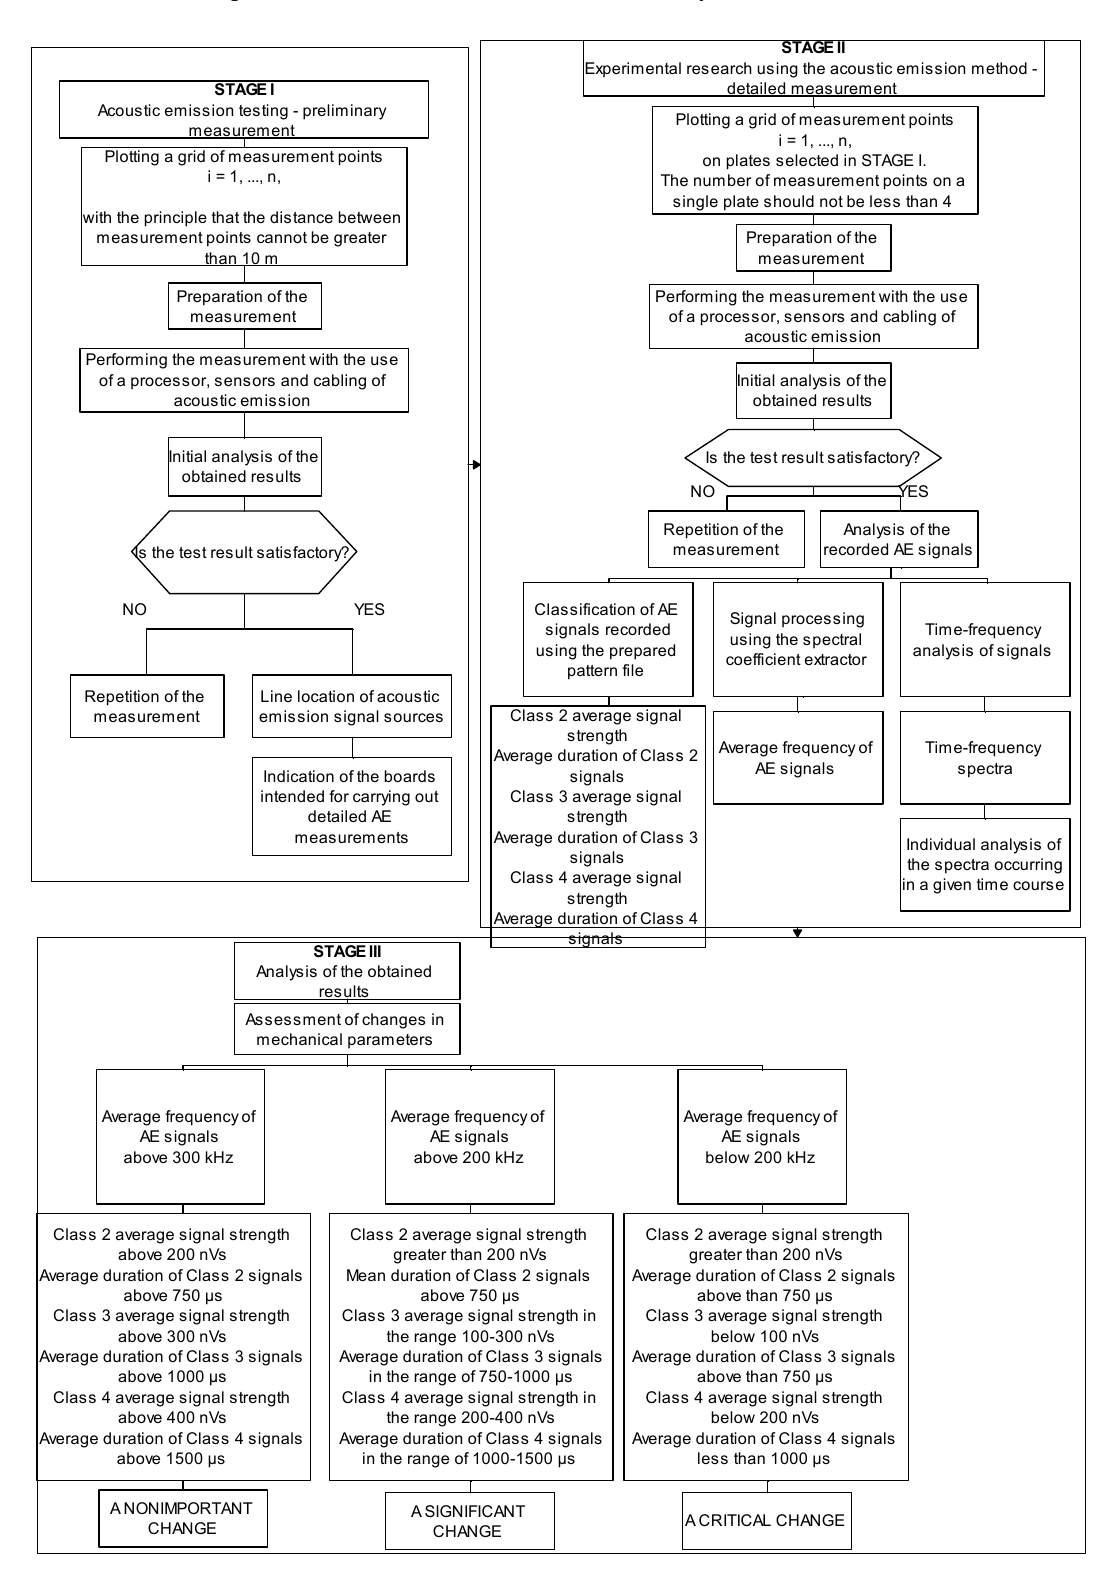
Figure 29. Diagram illustrating the methodology of assessing the change of mechanical parameters of fiber-cement boards under the influence of operational factors.